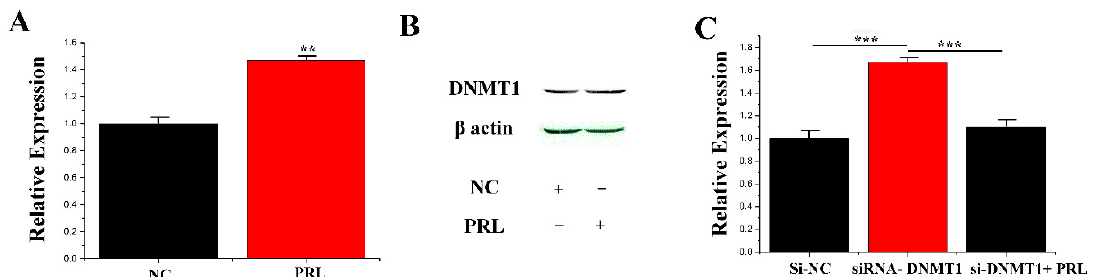
Figure 3. DNMT1 a ff ecting miR-183 expression. ( A ) The mRNA expression of DNMT1 was quantified. ( B ) Western blot of DNMT1 expression in the NC or PRL experiments. ( C ) The miR-183 expression level in CMECs. Values are presented as means ± standard deviation, ** p < 0.01; *** p < 0.001.